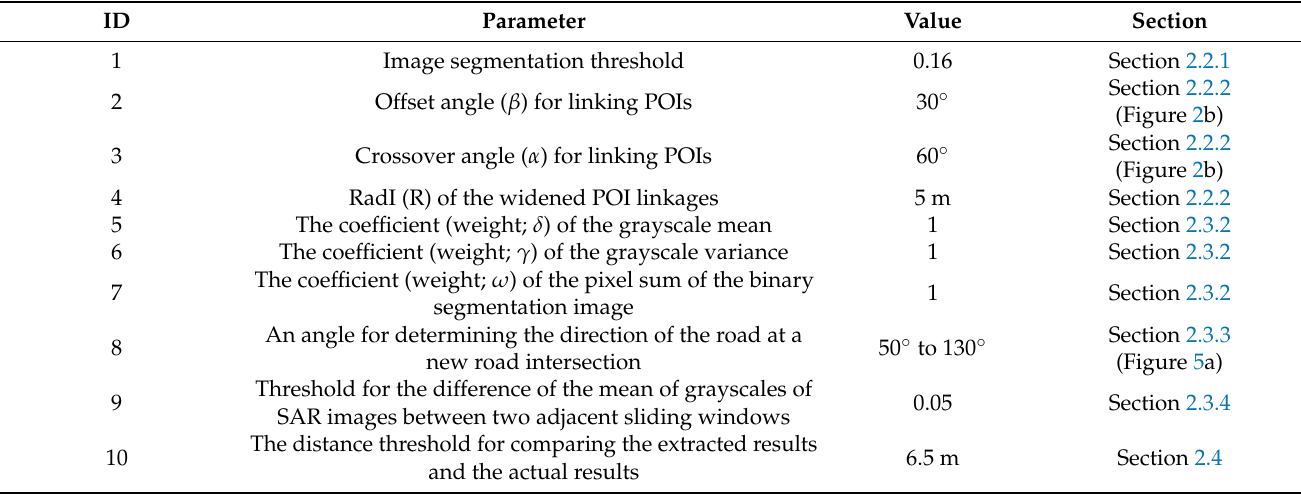
Table 3. A summary of the parameters and the thresholds used in this study.